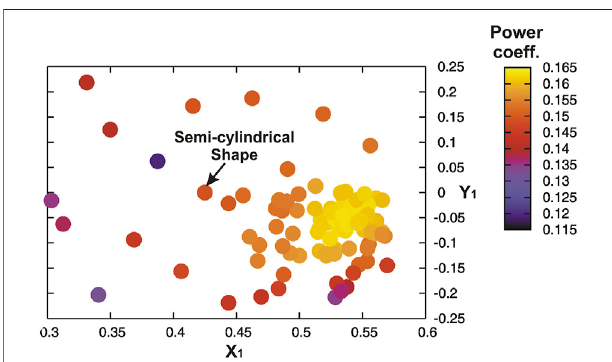
FIGURE 5 | Two – degree of freedom parameters of the optimization procedure and the power coef fi cient.